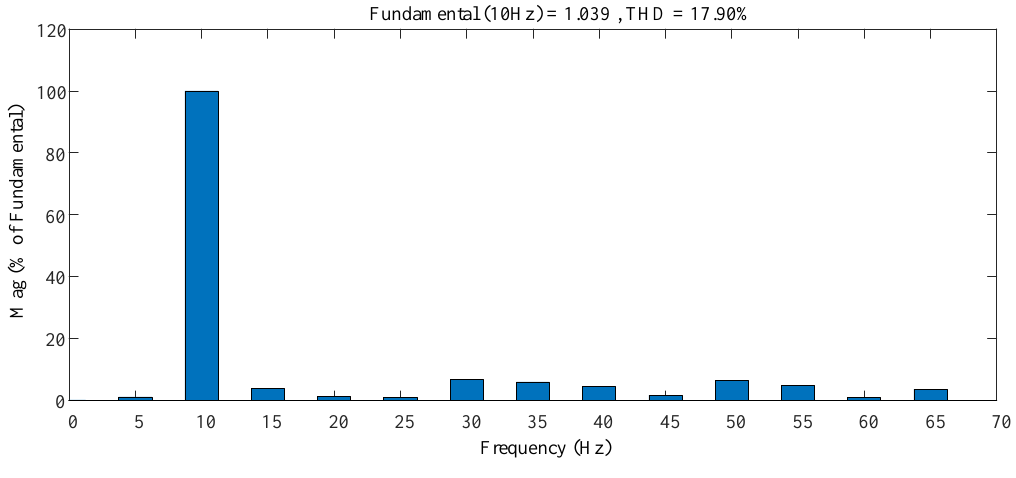
Figure 8. FFT decomposition of flux density with level-set optimization.